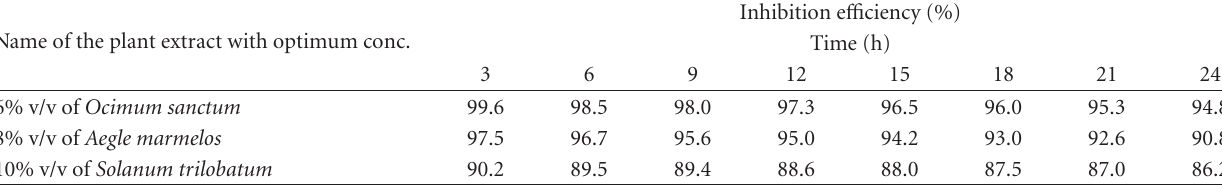
Table 2: E ff ect of immersion time on percentage inhibition e ffi ciency of mild steel in 1N HCl at 30 ◦ C in the presence of optimum concentration of the plant extracts.